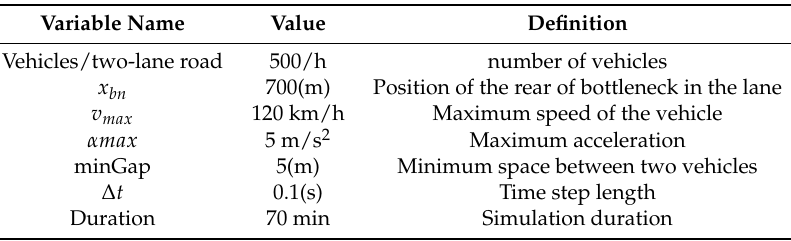
Table 4. Simulation parameters used in the